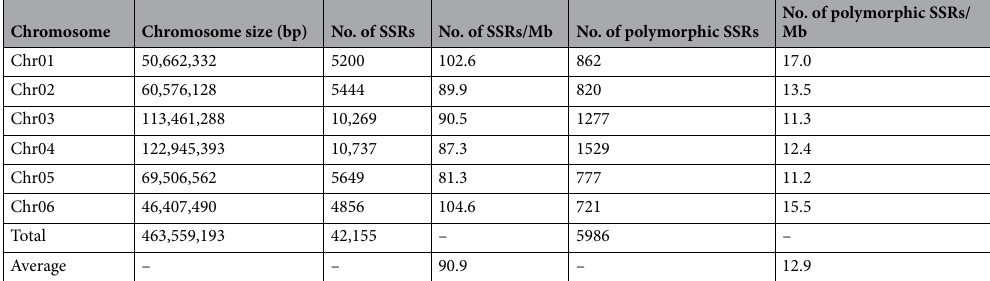
Table 1. Chromosome-wise distribution and density of the simple sequence repeat (SSR) loci in the spinach genome.